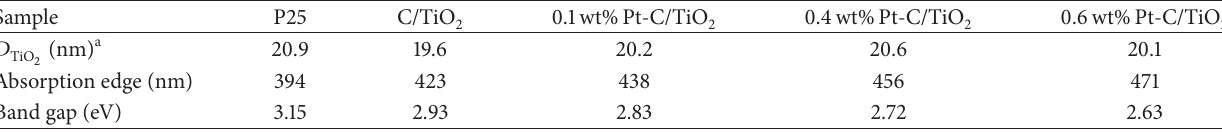
Table 1: Crystal sizes, absorption edges, and band gap energies of the synthesized samples.